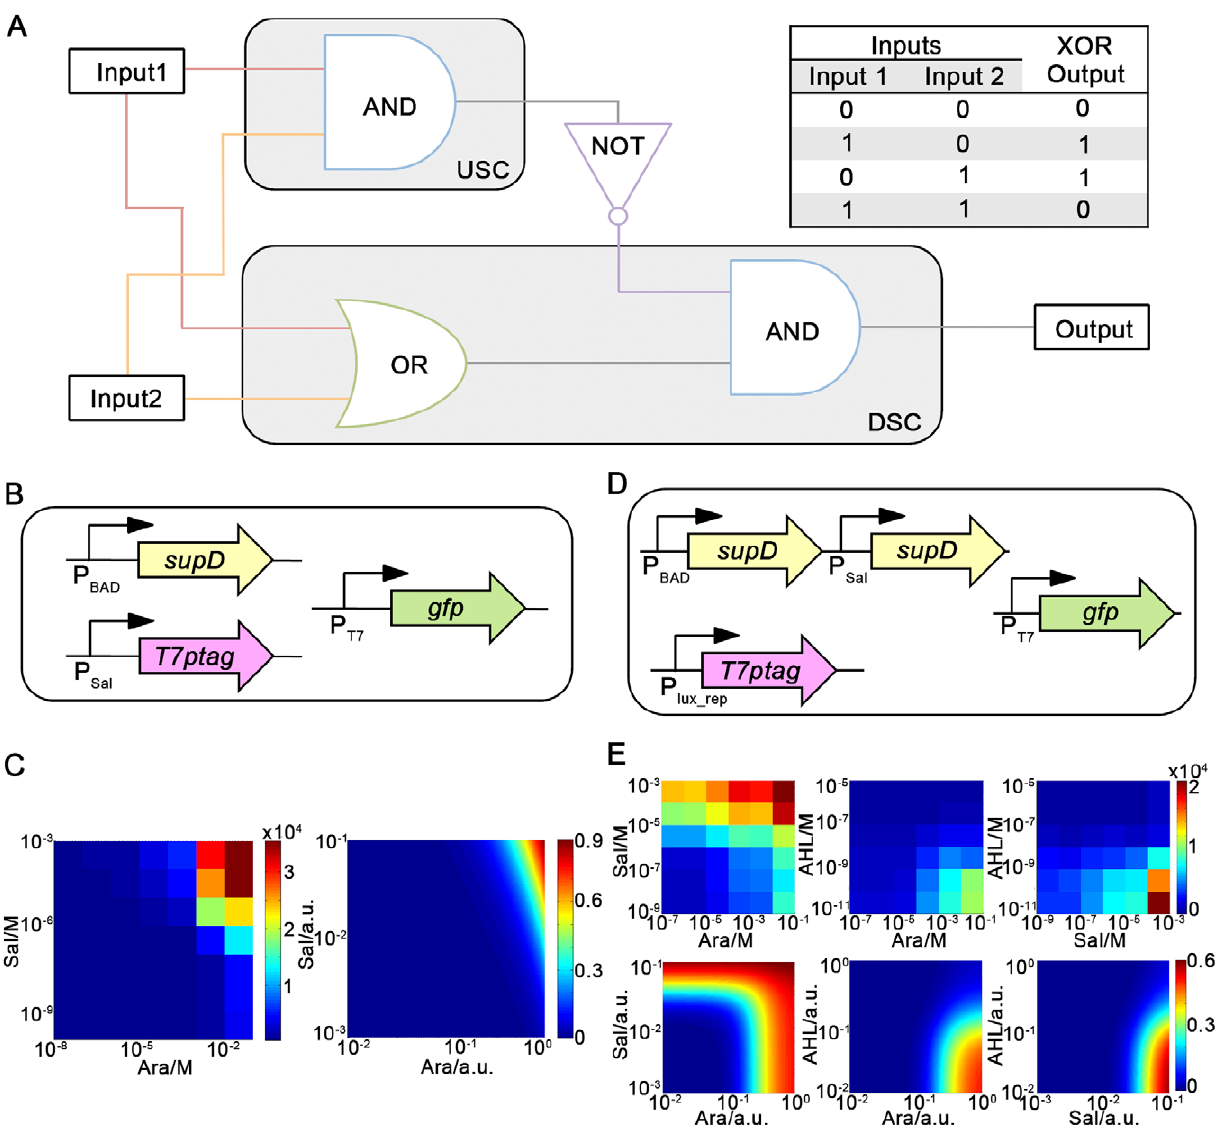
Figure 2. The simplest logic of XOR function, its distribution into separate logic operating cells, and characterization of two logic operators. (A). XOR function and its distribution. Left: The simplest logic of XOR gate expressed as the combination of basic logic units, according to the four rules in main text. XOR gate is distributed into two different logic-operating cells, USC and DSC. USC bears a genetic AND gate, with the output signal linked to DSC. DSC processes three inputs; two environmental inputs and an intermediate signal from USC. NOT gate does not belong to either cell, but is realized by transcription-inhibitory ‘‘chemical wire’’. Such construction satisfies truth table of XOR gate presented in the right panel. (B). Gene circuit to characterize transfer function of USC. Only when both inputs exist, functional T7 polymerase would activate T7 promoter and produce output, GFP. (C). Left: Experimental results for transfer function of USC. Florescence was measured and normalized by cell density. The measured sets are for 10 2 1 , 10 2 2 , 10 2 3 , 10 2 4 , 10 2 5 , 10 2 6 , 10 2 7 and 10 2 8 M arabinose, and 10 2 3 , 10 2 4 , 10 2 5 , 10 2 6 , 10 2 7 , 10 2 8 , 10 2 9 and 10 2 10 M salicylate. Right: Corresponding simulation prediction. (D). Gene circuit of DSC. Both environmental inputs can drive the expression supD tRNA through corresponding promoters, composing an OR gate. With no AHL, T7ptag would be expressed, and thereby GFP could be produced when either arabinose or salicylate (or both of them) present. (E). Transfer function of DSC, showing combinations of every two inputs. Columns from left to right: arabinose and salicylate, arabinose and AHL, and salicylate and AHL. Upper panels show experimental data compared with corresponding simulation prediction (lower panel). The data are for 10 2 1 , 10 2 2 , 10 2 3 , 10 2 4 , 10 2 5 , 10 2 6 , and 10 2 7 M arabinose, 10 2 3 , 10 2 4 , 10 2 5 , 10 2 6 , 10 2 7 , 10 2 8 , and 10 2 9 M salicylate, and 10 2 5 , 10 2 6 , 10 2 7 , 10 2 8 , 10 2 9 , 10 2 10 , and 10 2 11 M AHL. AHL was artificially supplied to DSC rather than a signal from USC. doi:10.1371/journal.pone.0057482.g002 combinations of arbitrary two inputs were tested, and all three salicylate is absent; however, DSC performs function of an experiments turned out satisfying. As shown in Fig. 2(E), when NIMPLY gate: only with salicylate or arabinose but no AHL, AHL is absent from the system, P lux_rep is always on; therefore output is ‘‘ON’’ [Fig. 2(E), middle and right panels]. Simulation output of DSC is ‘‘ON’’ when either arabinose or salicylate (or was also performed for DSC; the corresponding parameters were both of them) exists. As a result, DSC behave as an OR gate determined through fitting. [Fig. 2(E), left panel]. Under conditions either arabinose or